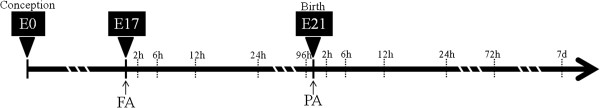
Experimental design. FA was induced at E17 by clamping the uterine vasculature for 30 min. At term birth, global PA was induced by placing the uterine horns containing the pups in a saline bath (37°C) for 19 min. All animals were delivered by Caesarean section. Pups were killed at five different time points after FA prenatally (n = 5 per group per time point) and six different time points postnatally (n = 4 per group per time point). E= embryonic day, FA= fetal asphyxia, PA= perinatal asphyxia.